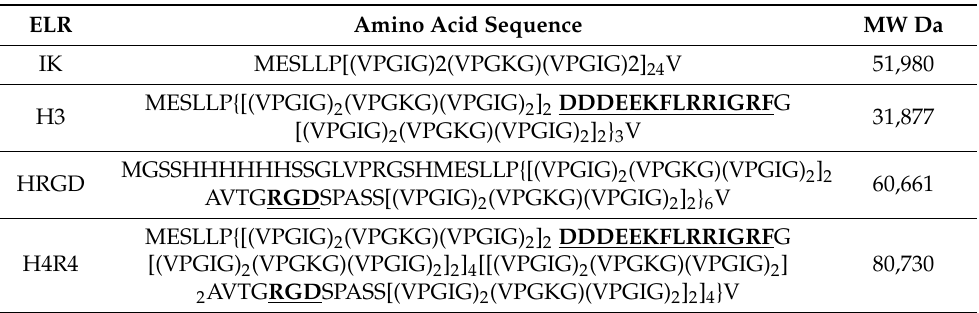
Table 1. Amino acid sequences of the different ELRs. The hydroxyapatite nucleation and the adhesion sequences are highlighted in bold and